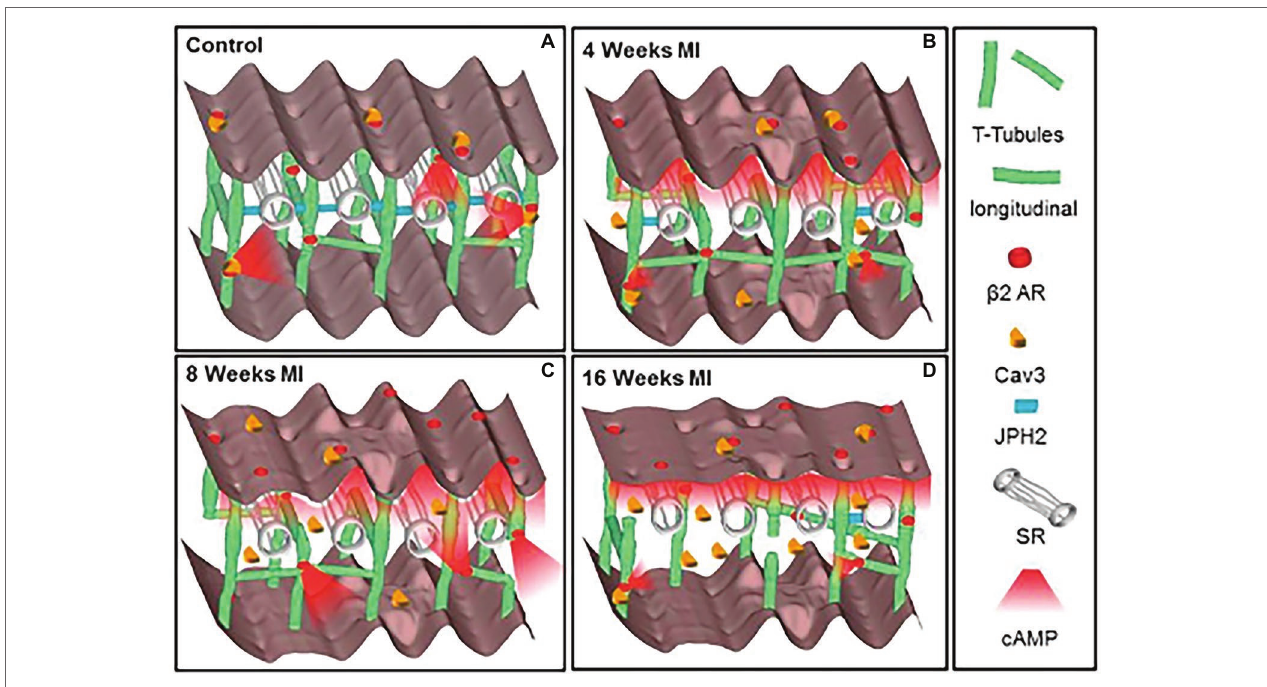
FIGURE 2 | Schematic of the changes in structure and location of β 2-ARs during heart failure progression. (A) In control CMs the external surface structure (Z-grooves and crests) and the internal transverse and axial tubules (TAT) network, are intact, and β 2-AR are located exclusively on T-tubules, connected with the SR through Junctophilin 2 (JPH2). cAMP does not diffuse far from the site of β 2-AR activation, and Caveolin-3 (Cav3) is predominantly on the cell membrane. In heart failure the surface structure deteriorates progressively. (B) Four weeks after myocardial infarction, JPH2 is downregulated, and the density of longitudinal elements increases. β 2-AR dependent cAMP responses appear at the crest, and cAMP is no longer confined to the site of β 2-AR activation. (C,D) At later time, the CM surface elements and T-tubule structure further deteriorate, with decreased density of longitudinal element. Notably, inefficient β 2-AR dependent AC activation leads to significant reduction in cAMP production. Adapted with permission from Schobesberger et al.